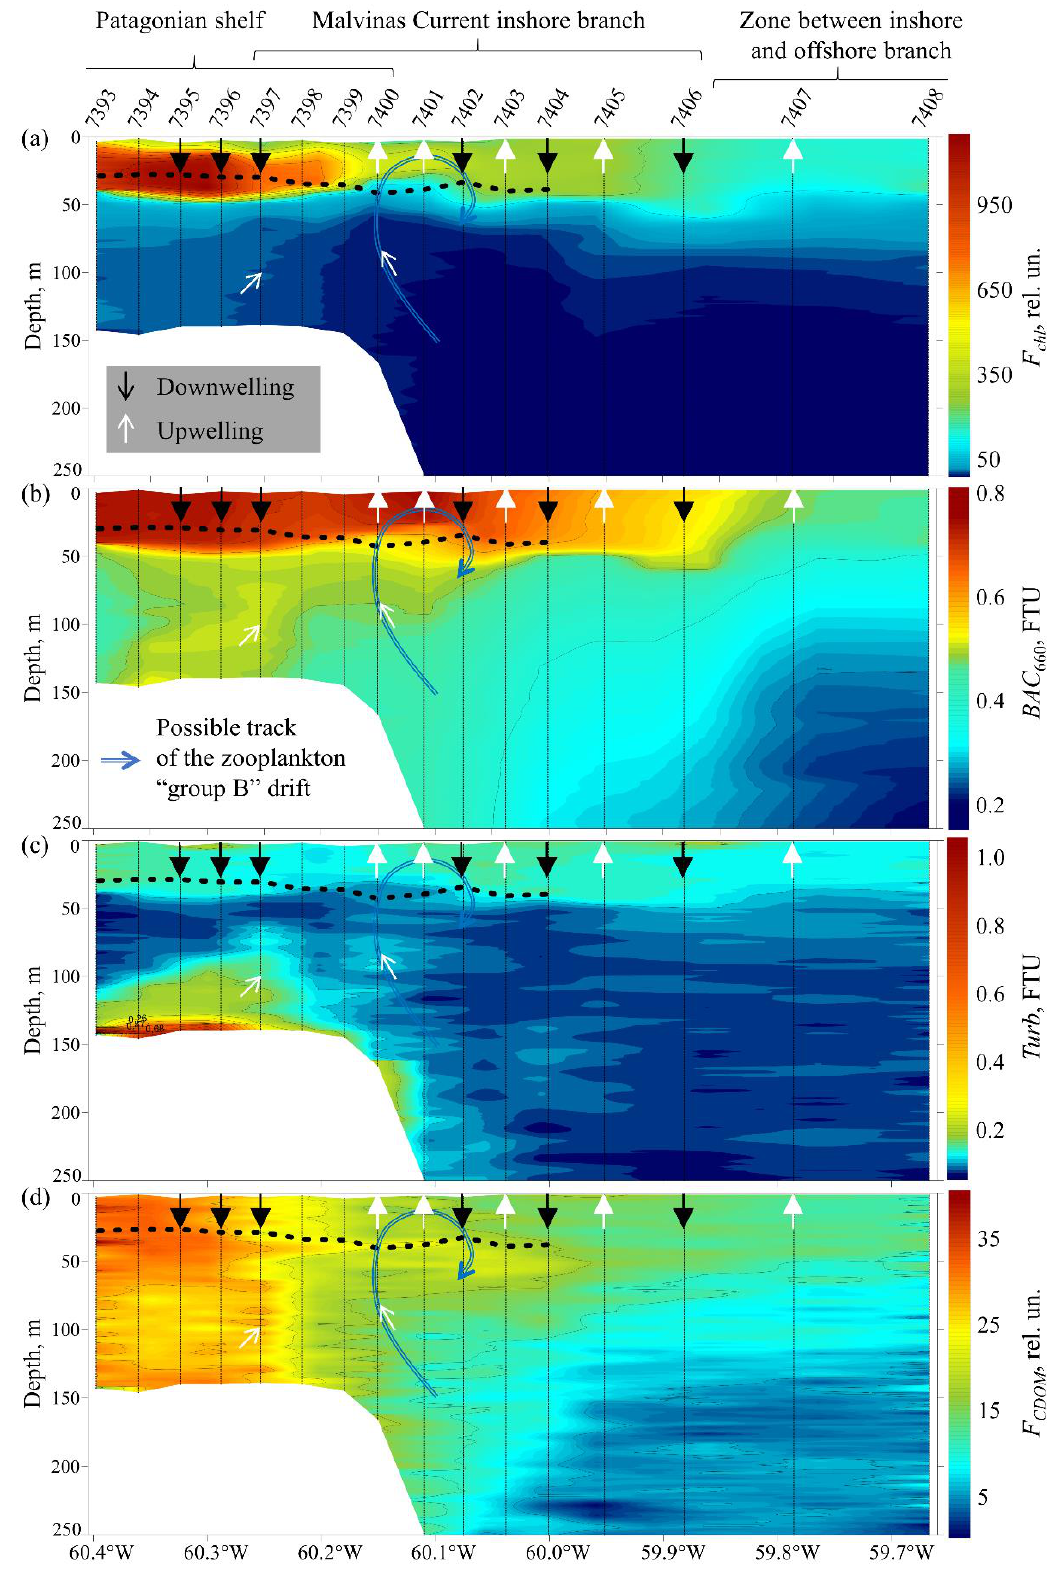
Figure 5. Sections of optical characteristics: intensity of chl- a fluorescence, F chl ( a ); beam attenuation coefficient at a wavelength of 660 nm, BAC 660 ( b ); turbidity, Turb ( c ); intensity of fluorescence of colored dissolved organic matter, F CDOM ( d ). Black dashed line indicates the euphotic depth Z eu .